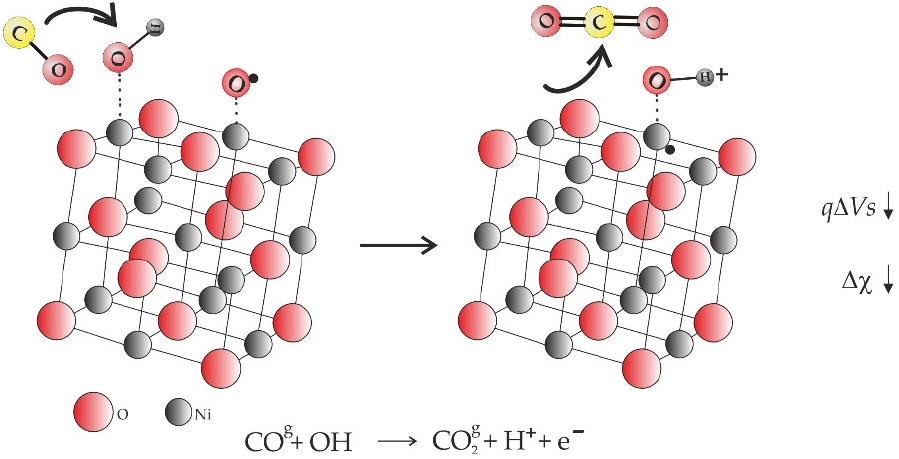
Figure 8. Intuitive cartoon of CO-sensing mechanism with NiO calcined at 400 °C.